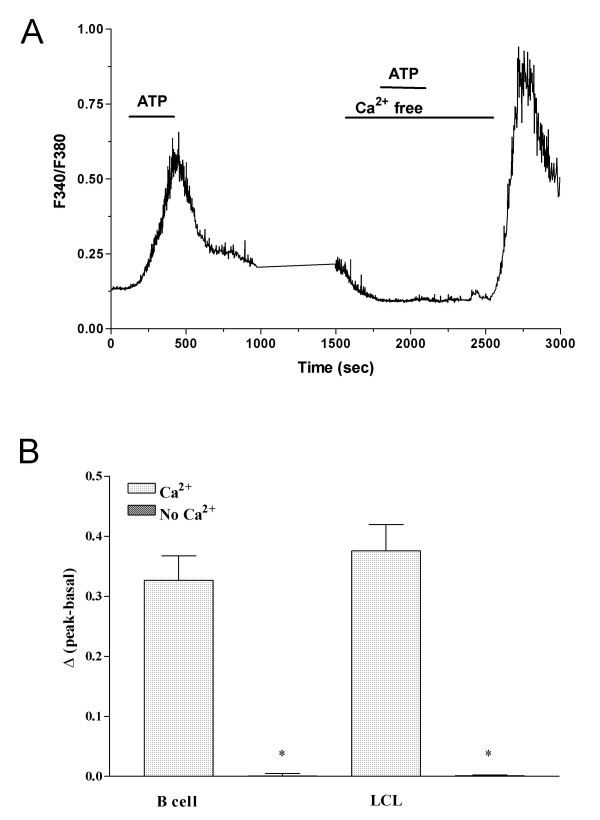
Effect of extracellular Ca2+-free conditions on [Ca2+]i induced by ATP. (A) Average time courses for Ca2+ responses induced by external perfusion of ATP (1 mM) in normal solution and the Ca2+-free solution in B cells (n = 4). Agent was applied as indicated by the horizontal bars above the traces. (B) Peak of ATP-induced [Ca2+]i rises during pretreatment with the Ca2+-free solution (n = 14 for B cells; n = 12 for LCLs). Data are the mean ± SEM; *p < 0.0001 compared to Ca2+ treated samples.